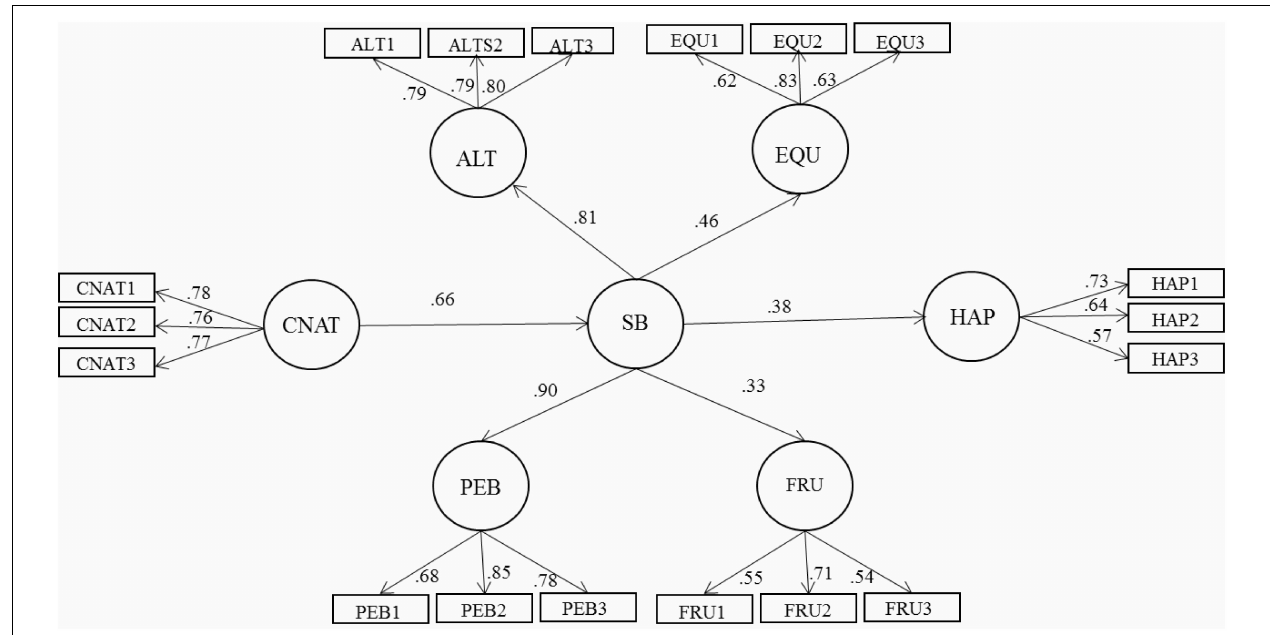
FIGURE 1 | Structural model of sustainable behavior and happiness, predicted by connectedness to nature. Goodness of fit: X 2 = 203.26 (125 d.f. ) p = 0.000, BBNFI = 0.90, BBNNFI = 0.94, CFI = 0.95; RMSEA = 0.04; R 2 Sustainable behavior = 0.42; R 2 Happiness =